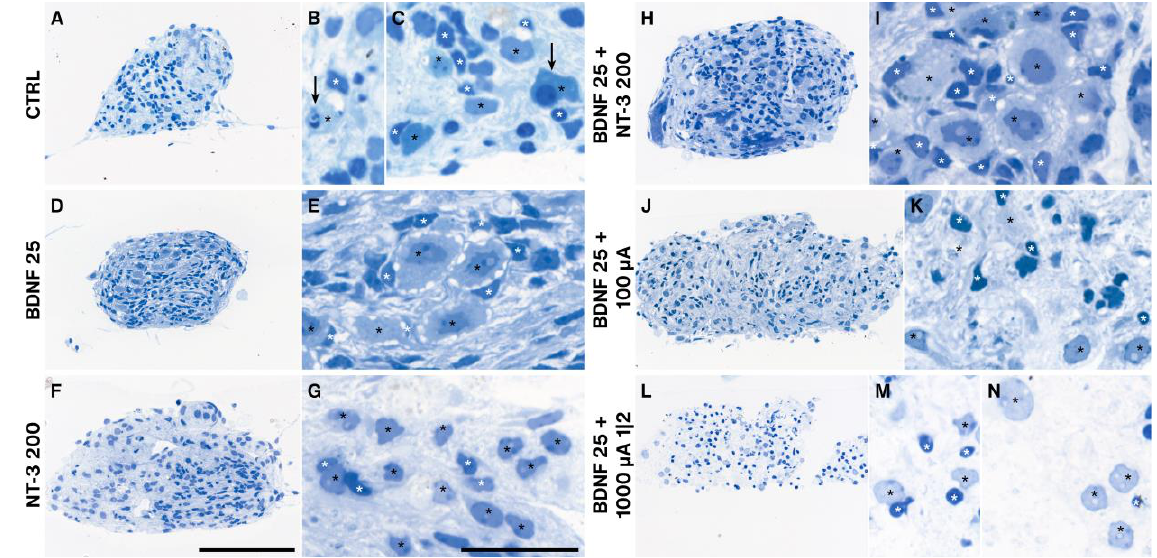
Figure 9. Semithin sections of BDNF and/or NT-3 supplemented, and electrical stimulated ex- plant cultures. Treatments influenced the cell morphology of SGNs (black stars) and ensheath- ing SGCs (white stars). Control explants without neurotrophic supplementation ( A – C ) exposed many degenerating neurons (arrows) and several SGCs. Explants after 25 ng/mL BDNF treatment ( D , E ) resembled a normal morphology with many SGCs ensheathing SGNs with big nucleoli. 200 ng/mL NT-3 administration ( F , G ) resulted in big neurons but fewer SGCs associated with these neurons. Combined BDNF and NT-3 ( H , I ) application showed a similar appearance as with BDNF alone, while ES at 100 µ A ( J , K ) and 1000 µ A and a 1 min on, 2 min off pattern ( L – N ) lead to a marked decline of SGCs. Often SGNs located without their SGCs in the explant tissue ( L , N ). Scale bars: 100 µ m (overview) and 10 µ m